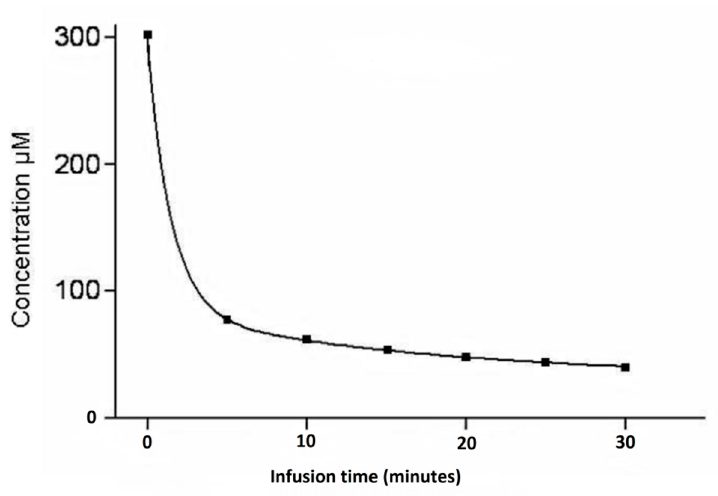
Figure 3. Typical melphalan concentration graph during isolated limb infusion.